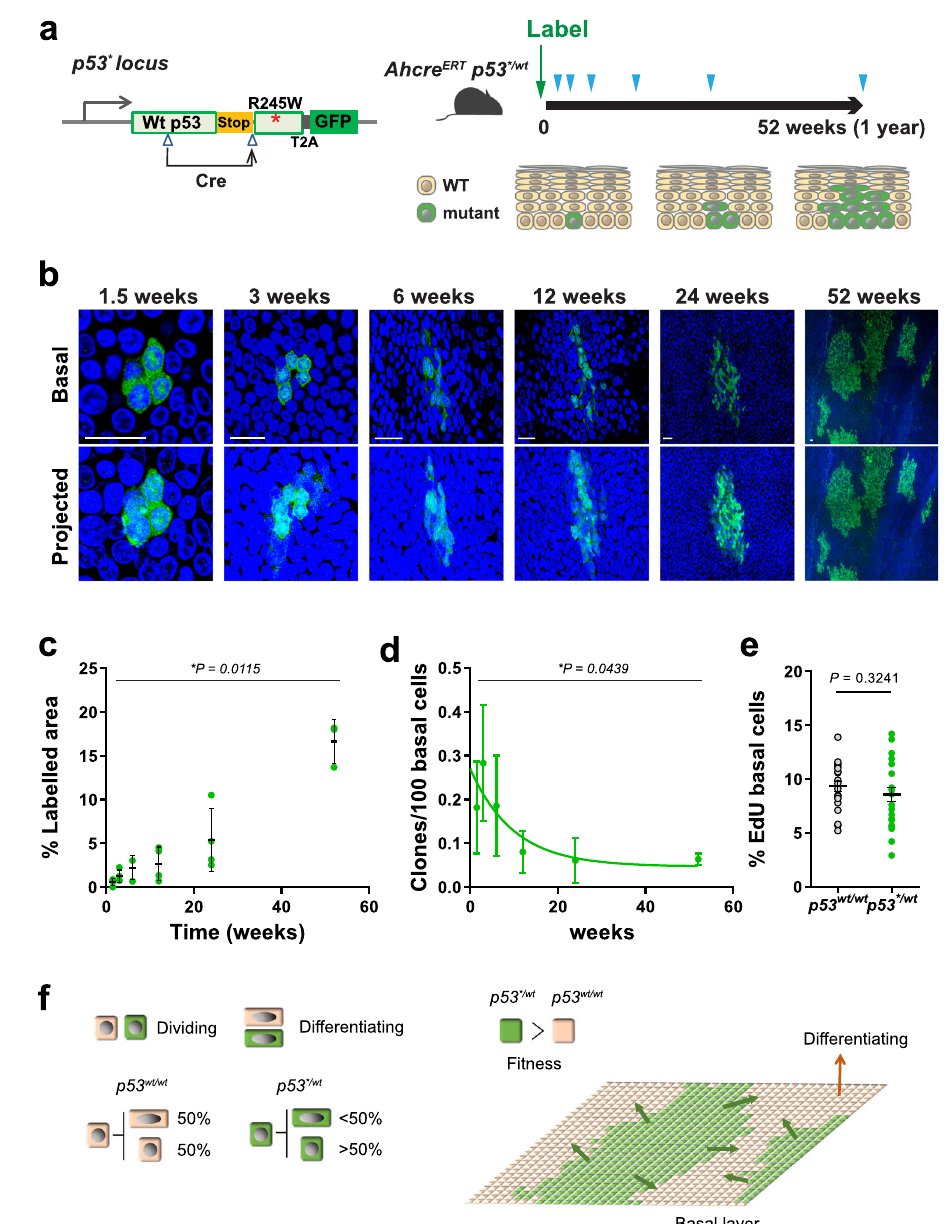
Fig. 2 | Heterozygous p53 R245W ( p53 */wt ) mutant cell fate in mouse oesophagus. a Protocolandschematicofgeneticlineagetracingin Ahcre ERT p53 fl R245W-GFP/wt ( p53 */wt ) mice.Expressionofthe p53 mutantalleleandGFPreporterwasinducedinscattered singlecells(Labelling)andoesophagussamplesweretakenatindicatedtimepoints (triangles). The fate of mutant clones was examined by tracking the expression of GFP. b – d n =4 mice per time point except n =3 at the 6-week and 52-week